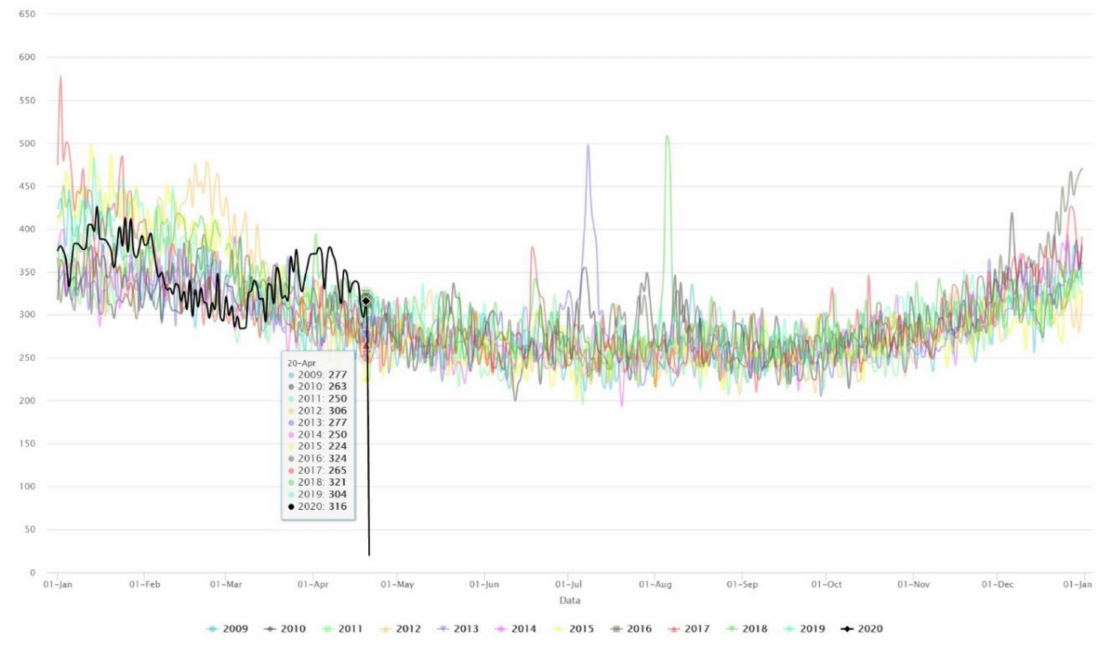
Figure 1. Daily mortality in Portugal from 2009 to April 2020